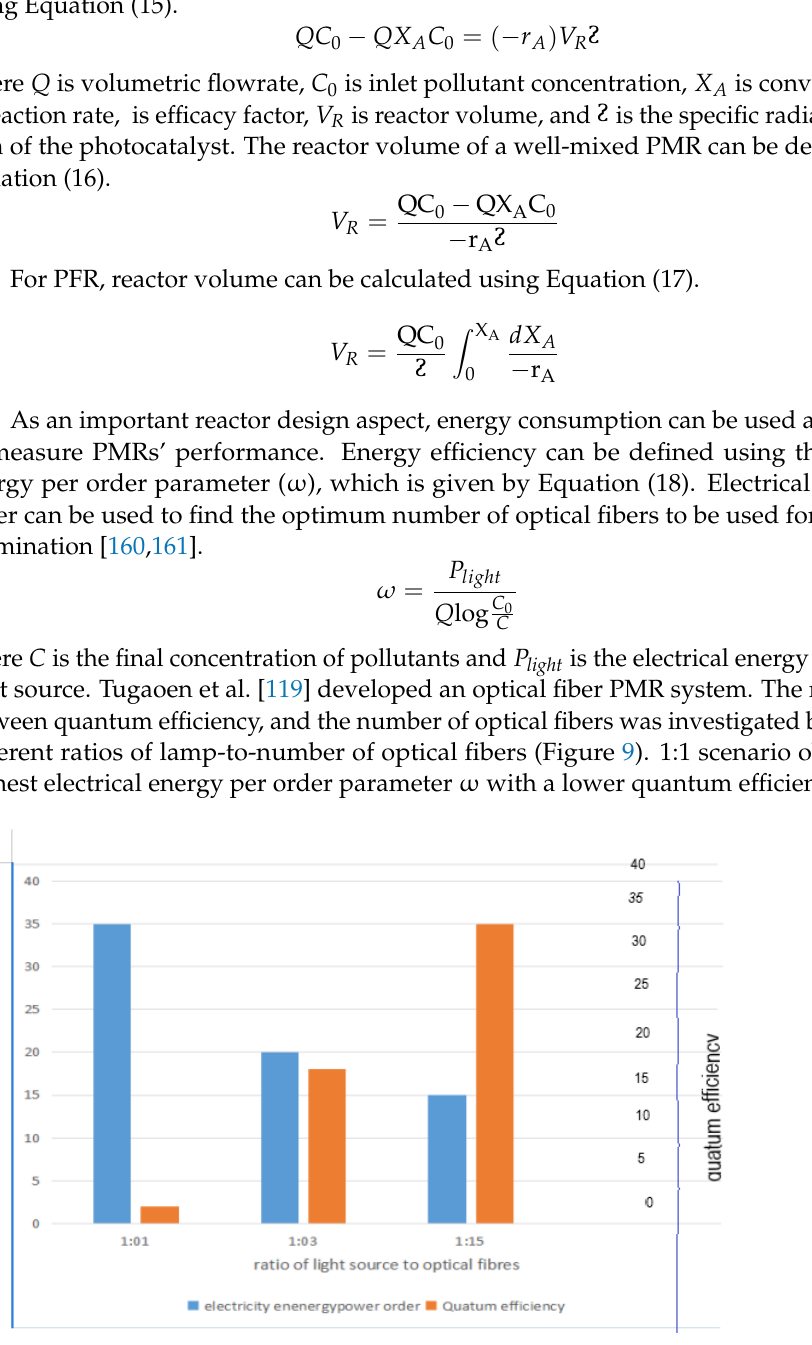
Figure 9. Relation between ω , quantum efficiency, and the number of optical fibers.